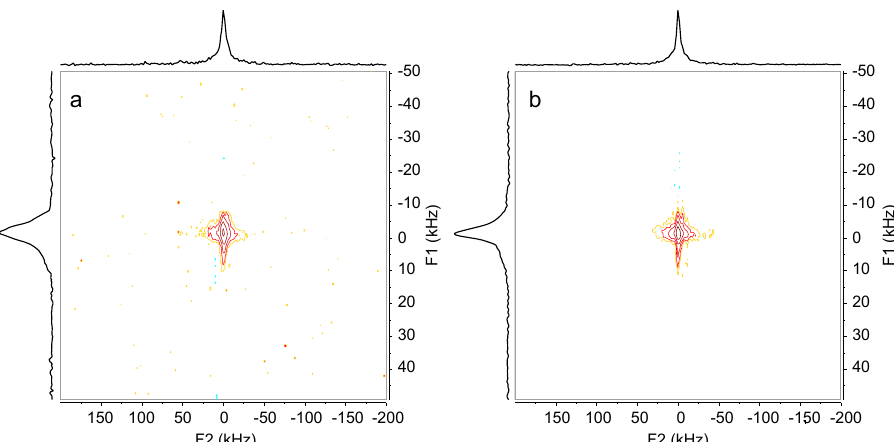
Fig. 2 Single- and double-resonance spin-echo experiments in the dark. Contour plots of the two-dimensional spin-echo experiments with ( a ) and without the S -spin fl ip (P3) pulse ( b ) measured in the dark, with τ L ¼ 20 min at 10 K. F1 and F2 are the frequencies corresponding to the Fourier transform of the t 1 and t 2 time domains in the SEDOR pulse sequence shown in Fig. 5, respectively. The one-dimensional spectra shown near the F1 and F2 axes are the cross-sections along the F1 and F2 directions that pass the peak intensity, respectively. The spectra projected onto the F2 axis are similar in the two cases, while those projected onto the F1 axis are different from each other due to the effect of the additional P3 pulse. This difference is due to the heteronuclear spin – spin coupling.